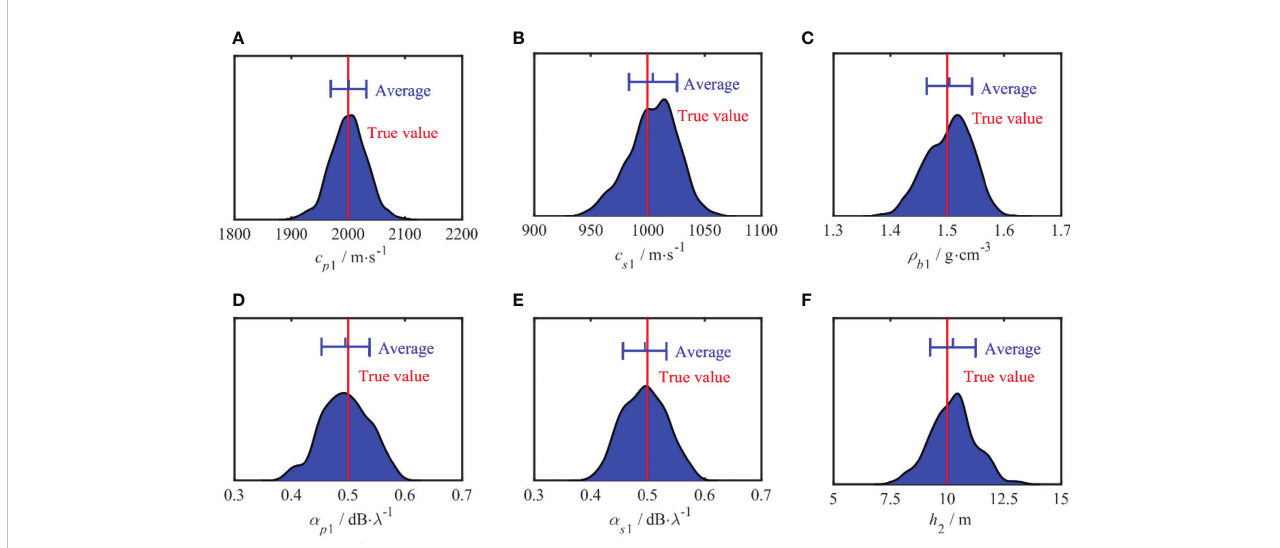
FIGURE 7 One-dimensional marginal probability distribution of sedimentary parameters. The red line means the true values of each parameter in simulation. The blue segments represent the average value and the standard